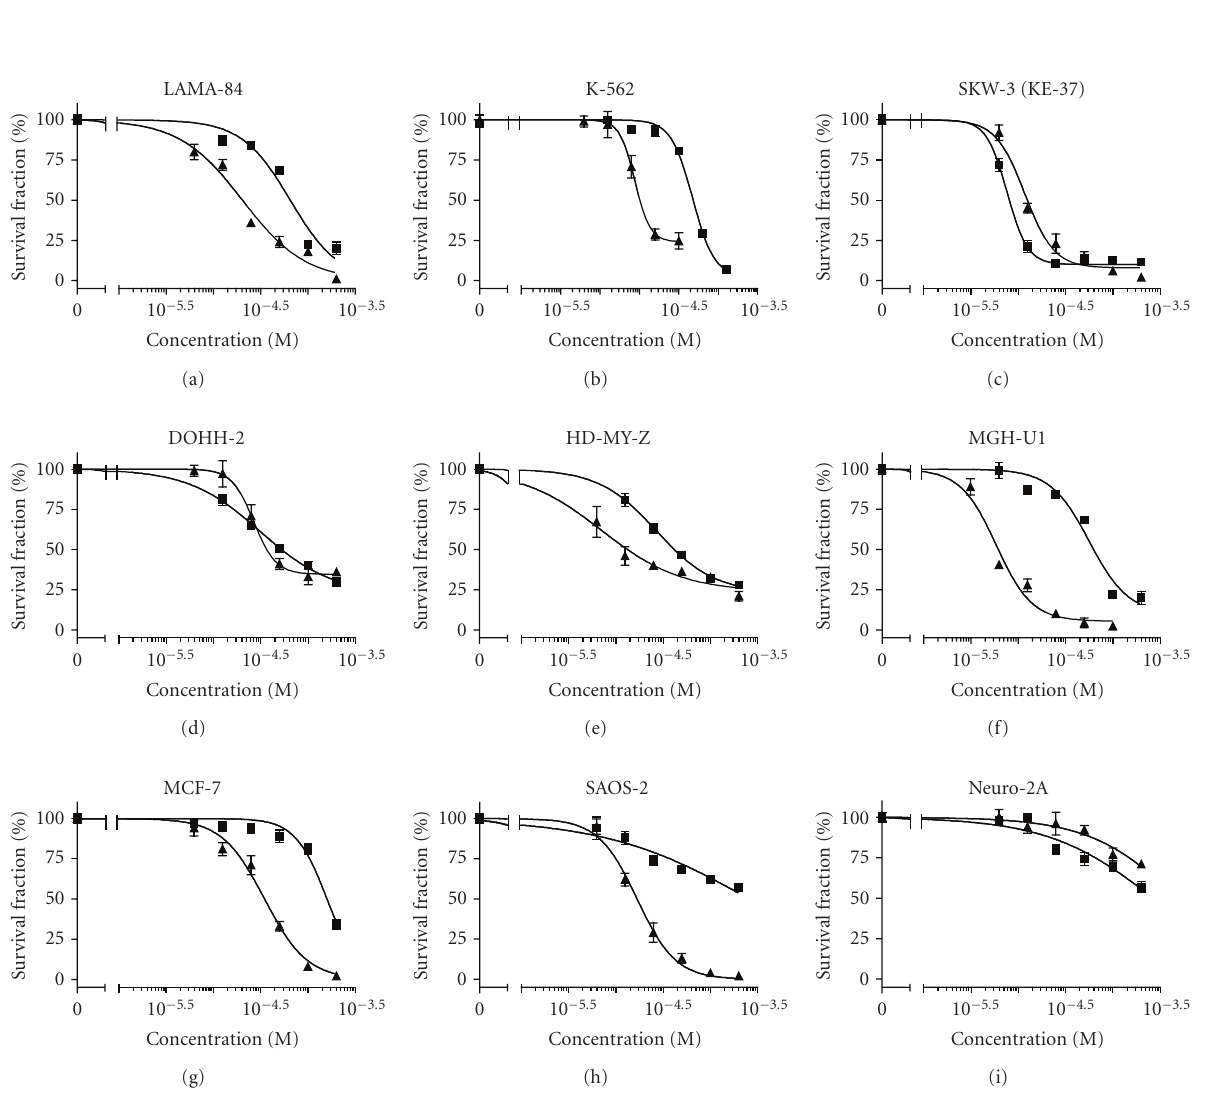
.(H 2 O) ] ( (cid:2) ) and cisplatin ( (cid:3) ) against a panel of tumor cell lines as assessed by 2 -2H